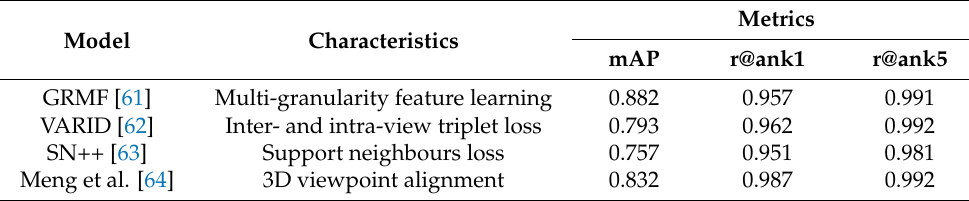
Table 3. Example of up-to-date solutions for vehicle re-identification.